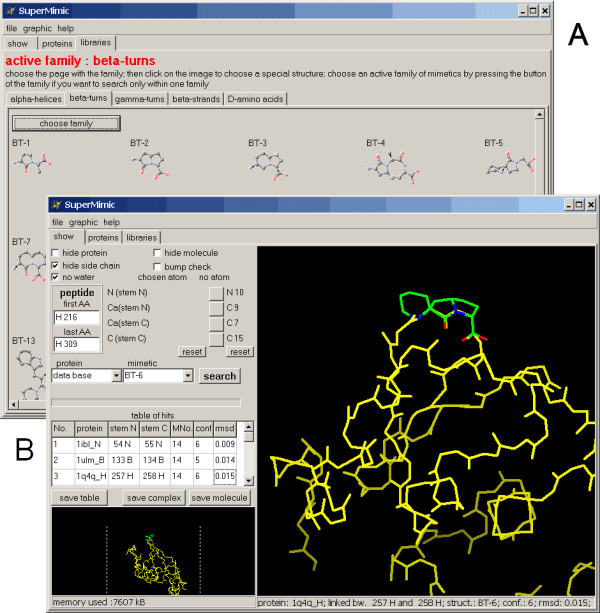
Screenshots of the SuperMimic program. A. Screenshot of the libraries of peptide mimetics, showing the family of beta-turn-mimetics. Searches can be performed within all conformations of one structure, within a family of mimetics, or within the whole library of mimetics. B. Screenshot after a search for suitable positions of a beta-turn-mimetic within the internal library of about 10403 PDB chains. The picture shows an apoptosis 1 inhibitor from Drosophila melanogaster, PDB-code 1q4q, chain H (yellow), with amino acids 257 and 258 replaced by the mimetic (green).